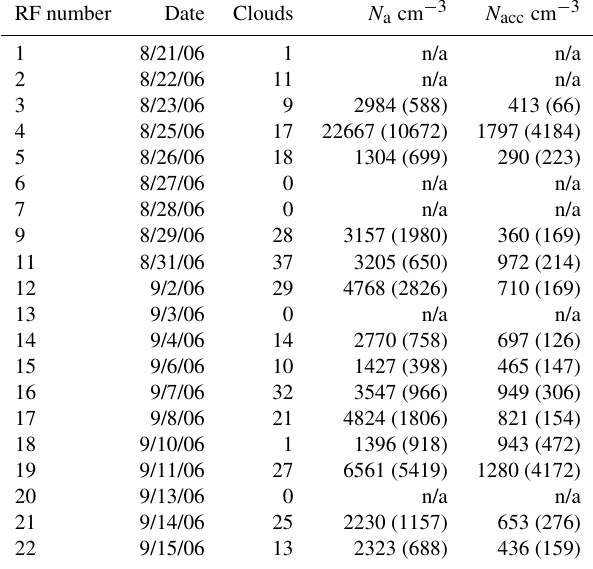
Table 1. Shows the flight information for 20 of the 22 flights that occurred during the GoMACCS campaign. Each flight corresponds to a RF number, date, the number of clouds (after filtering; see text), the total aerosol number concentration ( N a ), and the accumulation mode aerosol number concentration ( N acc ). Values in parentheses represent the standard